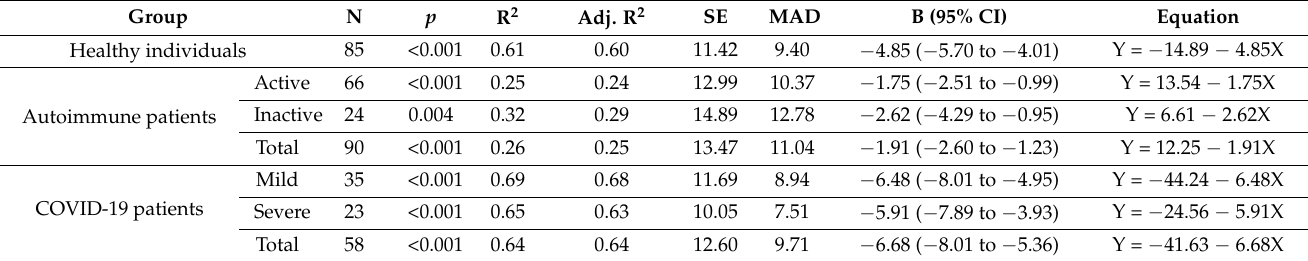
Table 3. Chronological age prediction conditioned on dCt (CtTBP − CtsjTREC) values in the different study